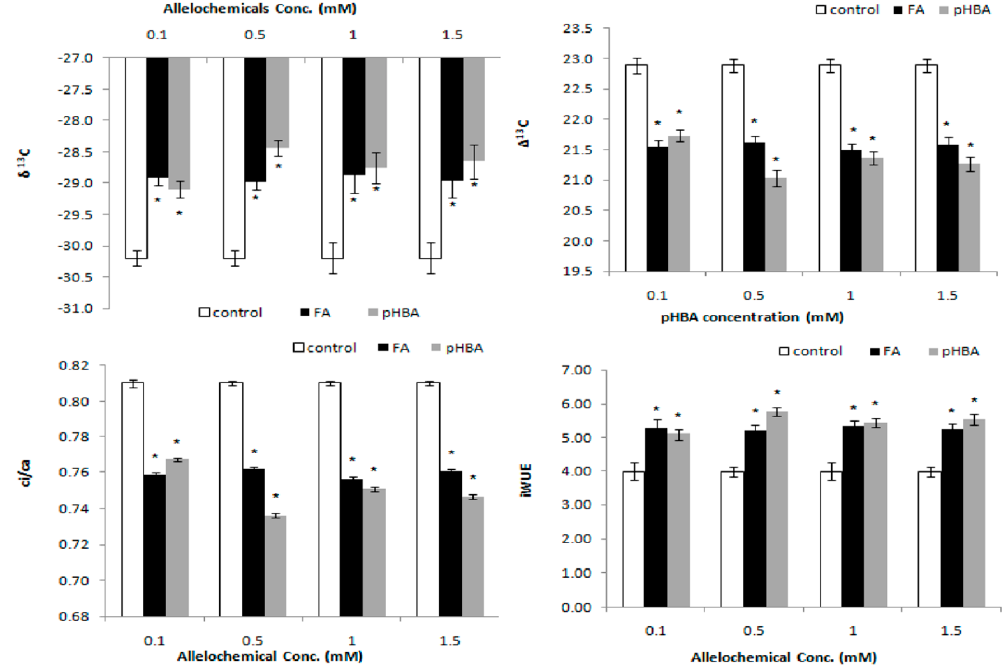
Figure 1. Changes following one-week exposure to ferulic acid (FA) and p -hydroxybenzoic acid (pHBA) at 0.1, 0.5, 1.0, 1.5 mM concentrations in: carbon isotope composition ( δ 13 C) ( A ); carbon isotopes discrimination ( ∆ 13 C) ( B ); ratio of CO 2 from leaf to air ( C i/ C a) ( C ); and intrinsic water use efficiency (iWUE) in leaves of Rumex acetosa ( D ). * Asterisk indicates significant differences at p ≤ 0.05 with respect to control.